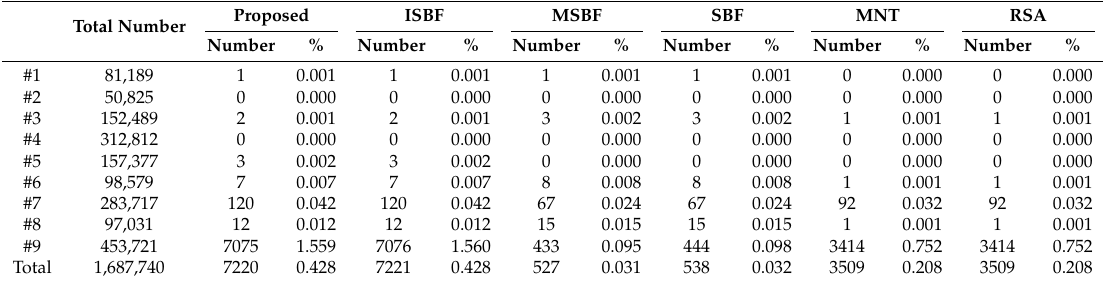
Table 11. Increases of pixels traced by the bidirectional scan from the one-directional scan.